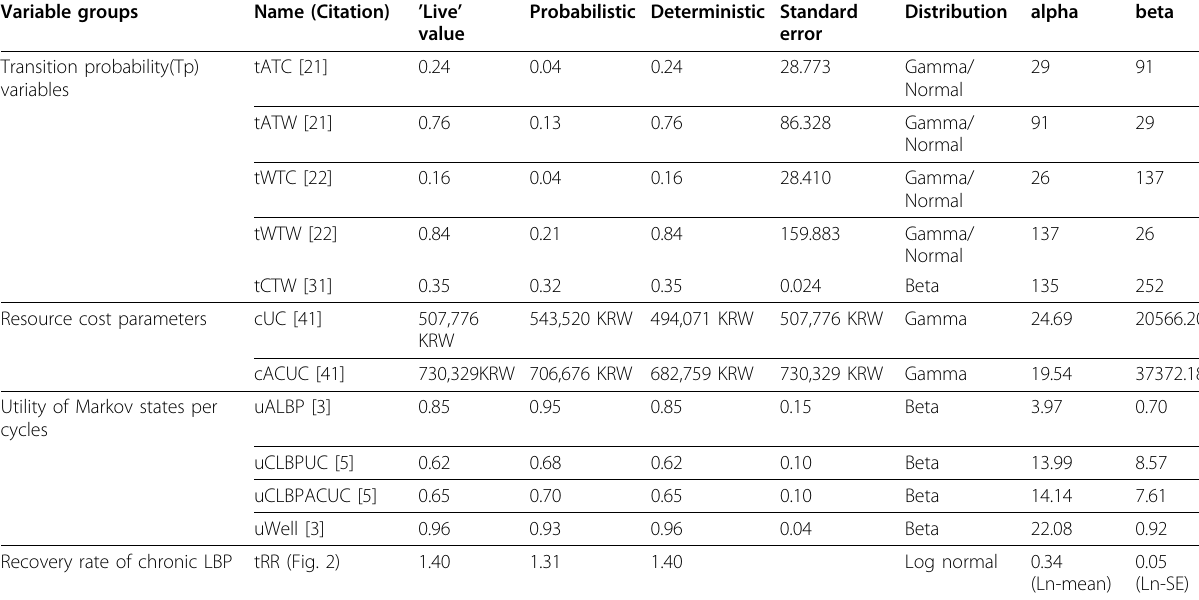
Table 3 Parameter values and distributions examined in sensitivity analyses Variable groups